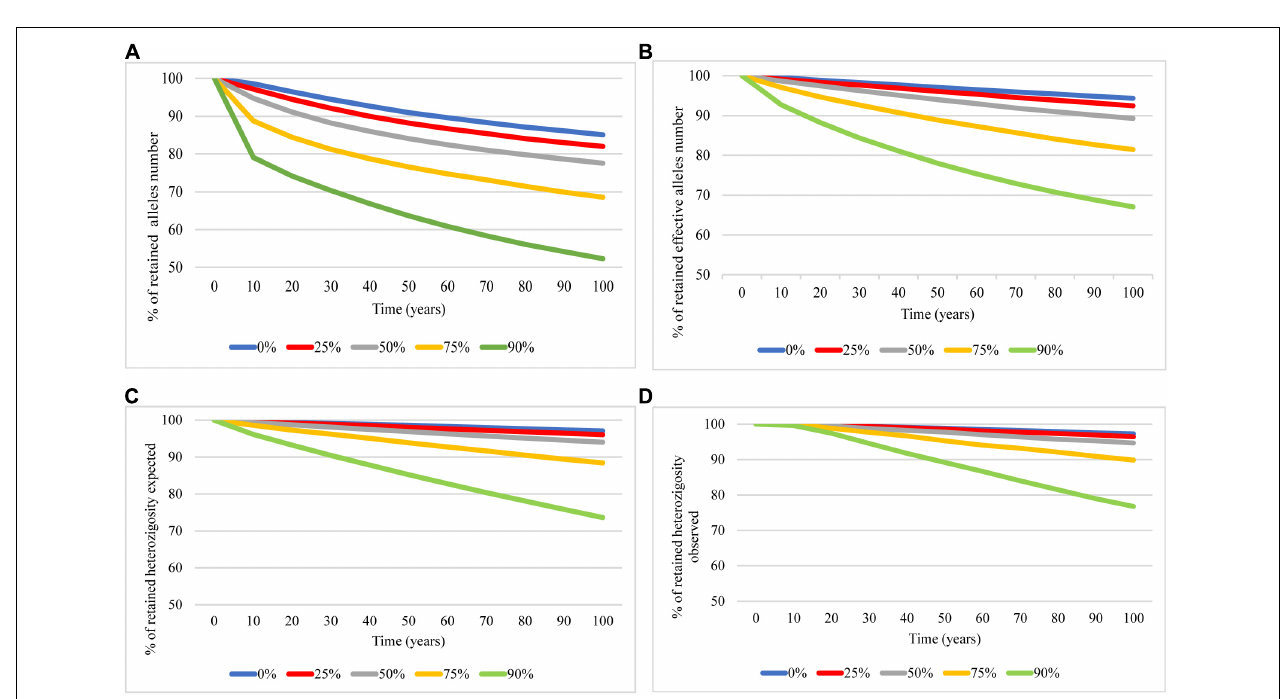
FIGURE 4 | Predicted genetic diversity in Myrmecophaga tridactyla over next 100 years when retained 100% (blue), 75% (red), 50% (gray), 25% (yellow), and 10% (green) of the current effective population size using BOTTLESIM program. (A) Number of alleles. (B) Number of effective alleles. (C) Expected heterozygosity. (D) Observed